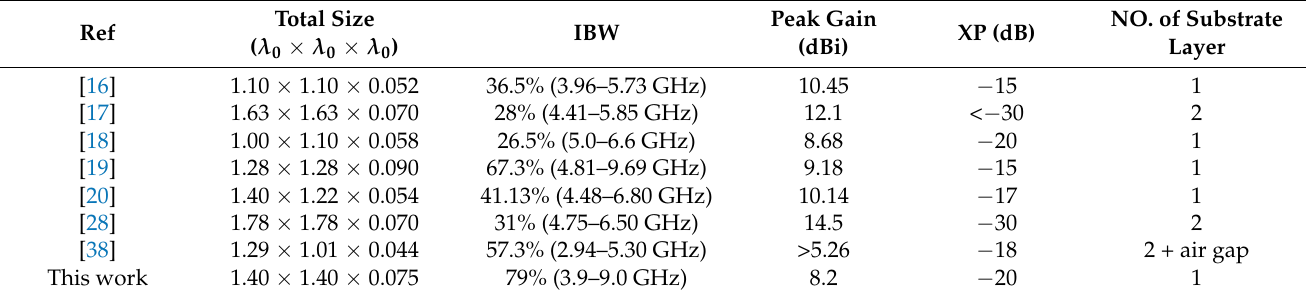
Table 1. Comparison of merits with some previously reported metasurface antennas.